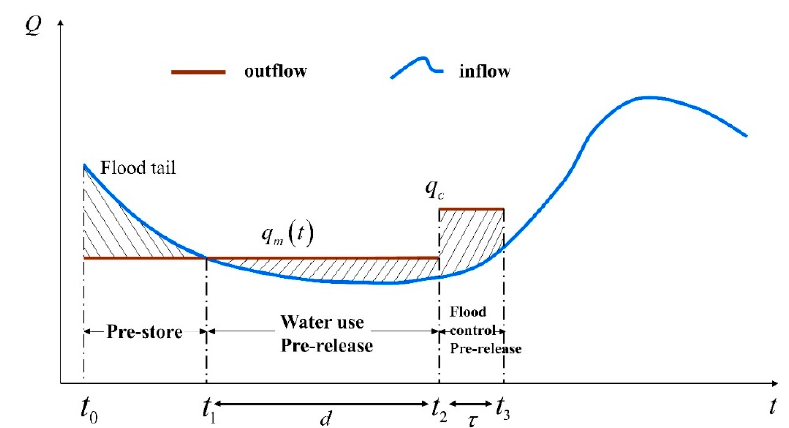
Figure 1. Two-period capacity-constrained pre-release method. Note: outflow is the drainage process of the reservoir; inflow is the reservoir inflow process; flood tail is the recession flood stage of the last flood; t 0 is the pre-store time; t 1 is the water use pre-release time; t 2 is the flood control pre-release time; d is the continuous dry period duration, τ is the flood forecast lead time, q m ( t ) is the daily average utilization discharge (mainly for power generation and various types of water supply) in the dry period, and q c is the average flood outflow in the flood forecast period.